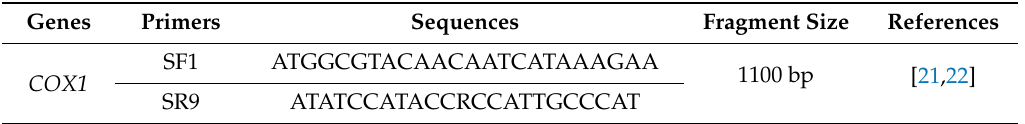
Table 1. List of primers used for the amplification of genes encoding c oxidase subunit I gene (COX1) in Sarcocystis